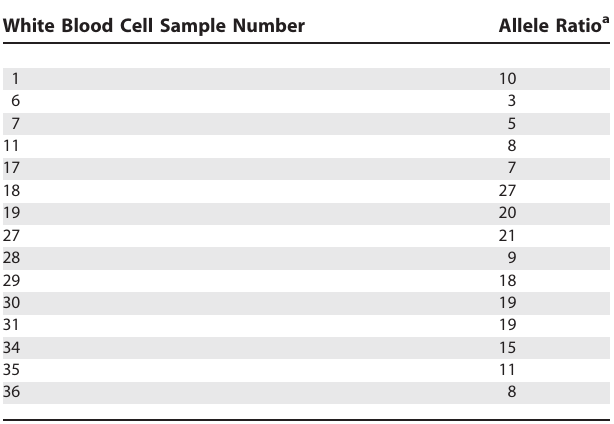
Table 1. Ratio of KRT1 Exonic SNP2 Allele Frequencies in Heterozygote White Blood Cell Samples as Determined by Real- Time PCR White Blood Cell Sample Number Allele Ratio